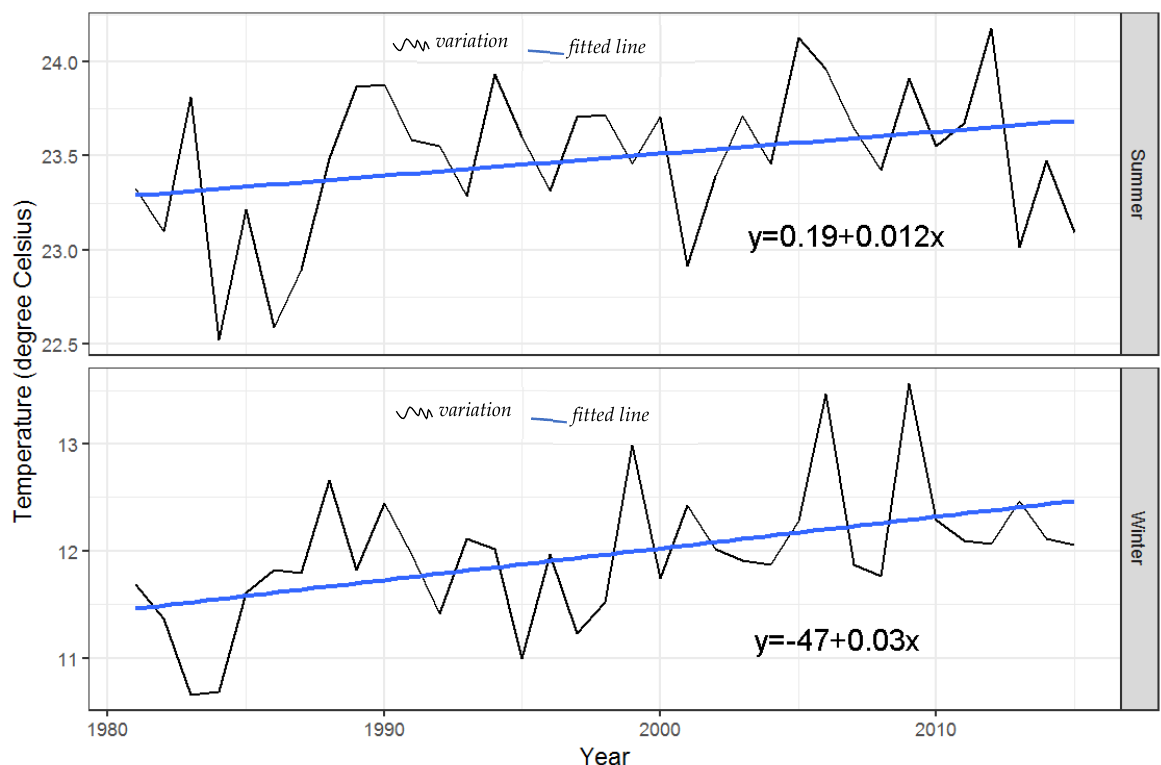
Figure 10. Trend of seasonal mean temperature in the study area.